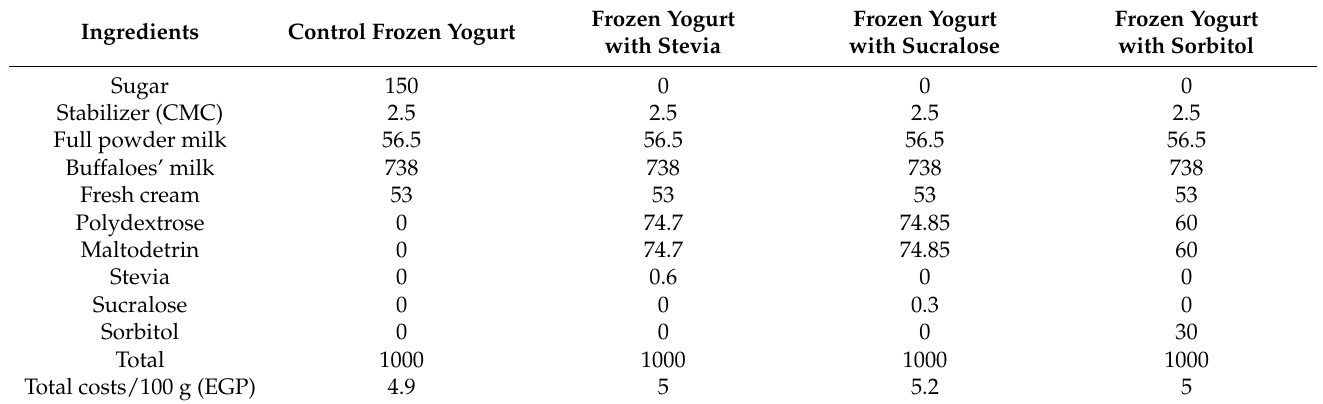
Table 1. Incorporation of different probiotic-frozen yogurt treatments